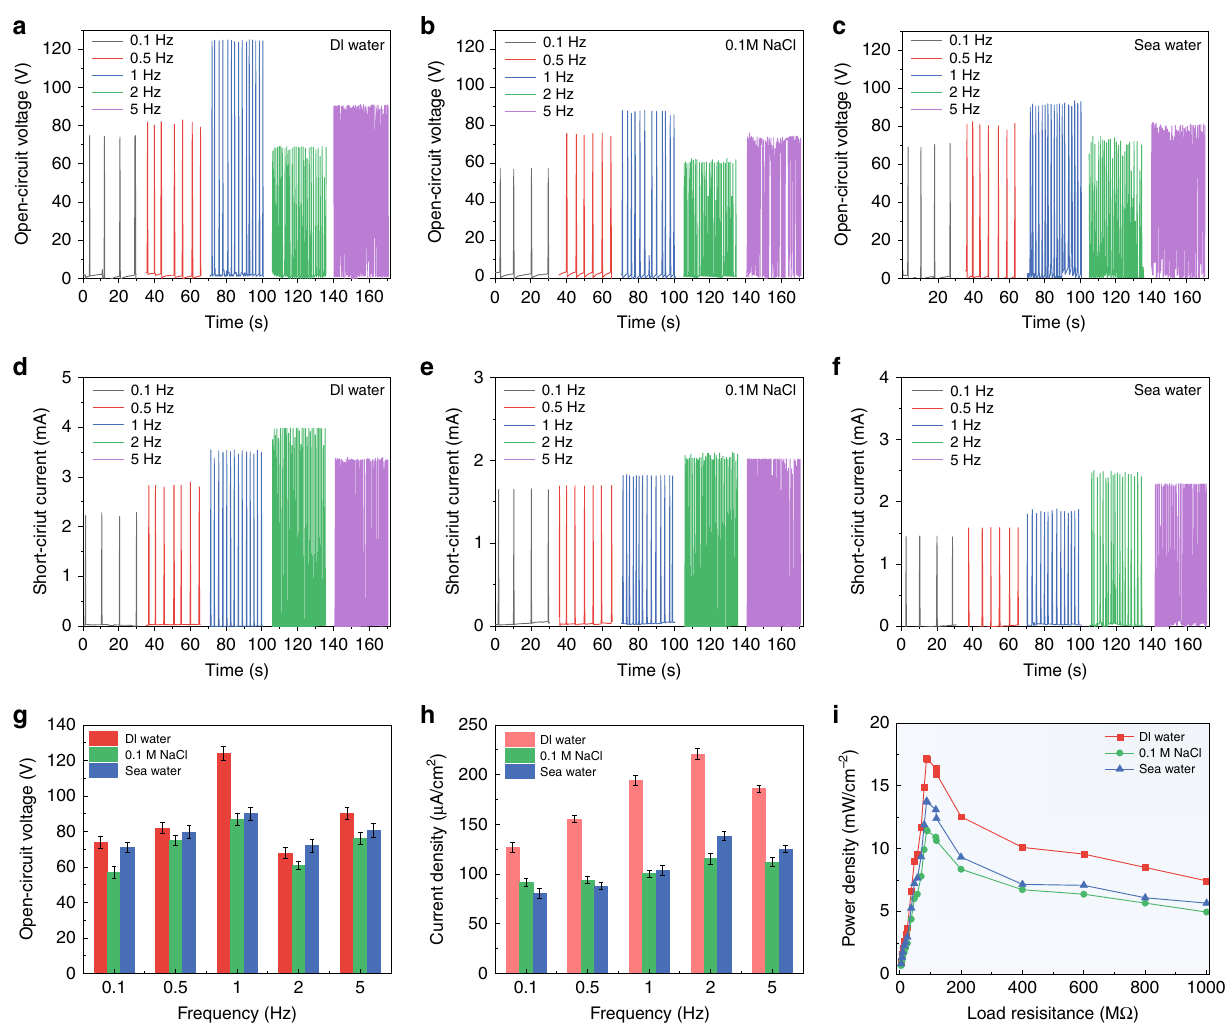
Fig. 5 Effects of water wave on the electrical performance. a , d The effects of DI water on the electrical performance of Pem-iTENG. b , e The effects of 0.1 M (mol/L) NaCl solution on the electrical performance of Pem-iTENG. c , f The effects of sea water on electrical output performance of Pem-iTENG. g , h , i The frequency dependence of the open-circuit voltage, short-circuit current density and power density 37 of Pem-iTENG working in three liquids,